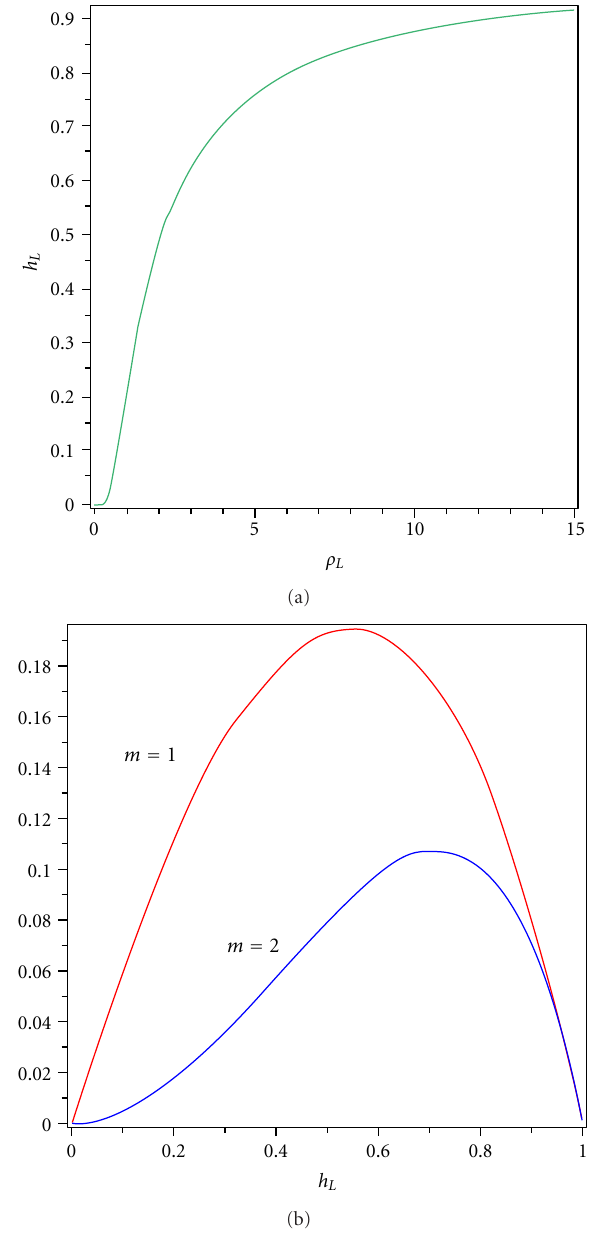
Figure 7: Estimates for diverse BA networks with N l = N/L , p l = p , and q l = q for all l . (a) Average fraction of infected nodes h L as a function of the average spreading rate ρ L . (b) Probability of node being isolated and not infected as a function of h L